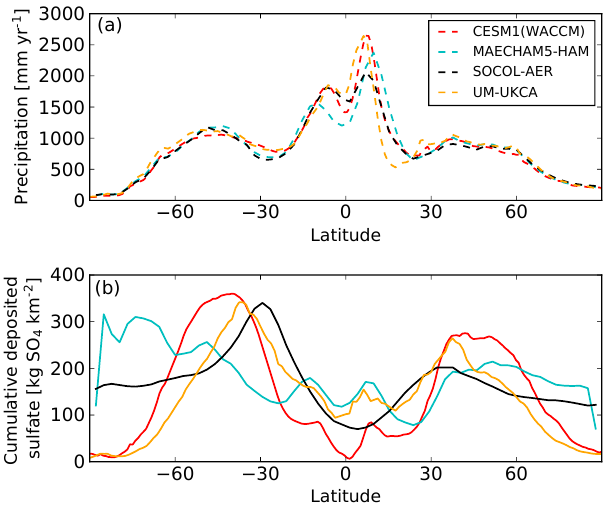
Figure 8. Zonal mean precipitation (mmyr − 1 ) averaged over the first 4 years after the eruption ( a , dashed lines) and zonal mean cu- mulative deposited sulfate (kgSO 4 km − 2 ) in the first 4 years after the eruption ( b , solid lines) for the ensemble mean in each model